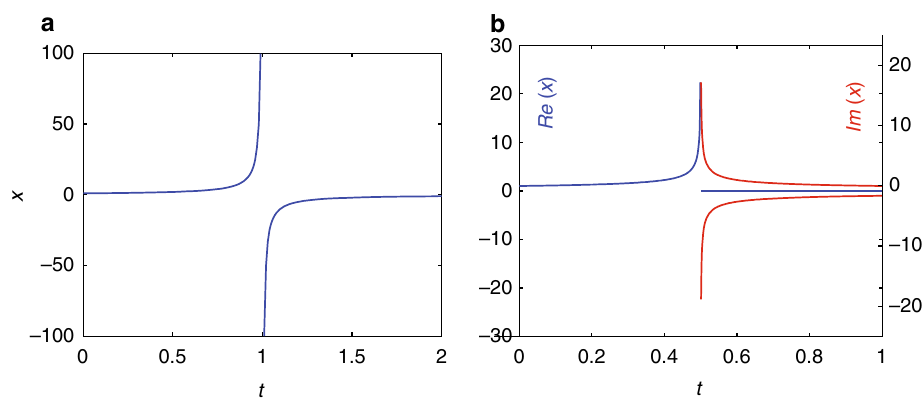
Fig. 1 In fi nity crossing in ODEs. The cases of a _ x ¼ x 2 , x (0) = 1 leading to collapse at t ⋆ = 1 and, b of _ x ¼ x 3 , x (0) = 1, leading to collapse at t * = 0.5; in this case x ( t ) becomes imaginary beyond t * (see also